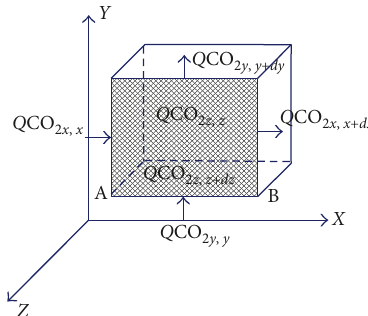
Figure 3: Schematic diagram of mass transfer of element on the